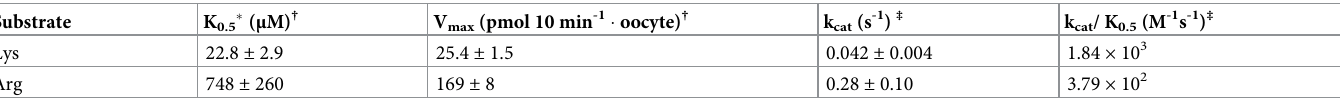
Table 1. Tg ApiAT6-1 steady-state kinetic parameters for Lys and Arg.